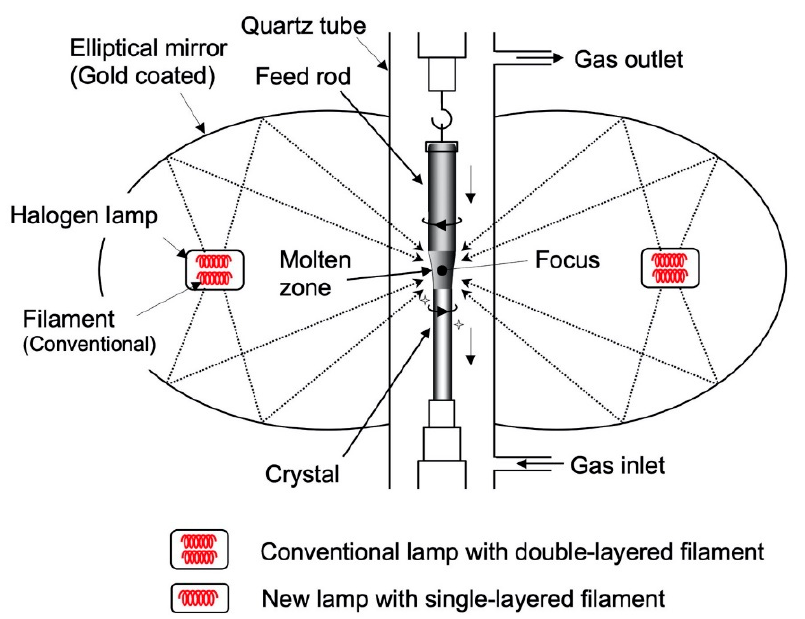
Figure 1. Schematic drawing of an infrared image furnace with double elliptical mirrors. In this study, we focus on the improvement of the crystal growth of Sr 2 RuO 4 by introducing a new filament. Here, the new filament has a single layered, whereas the conventional one has a double-layered structure.